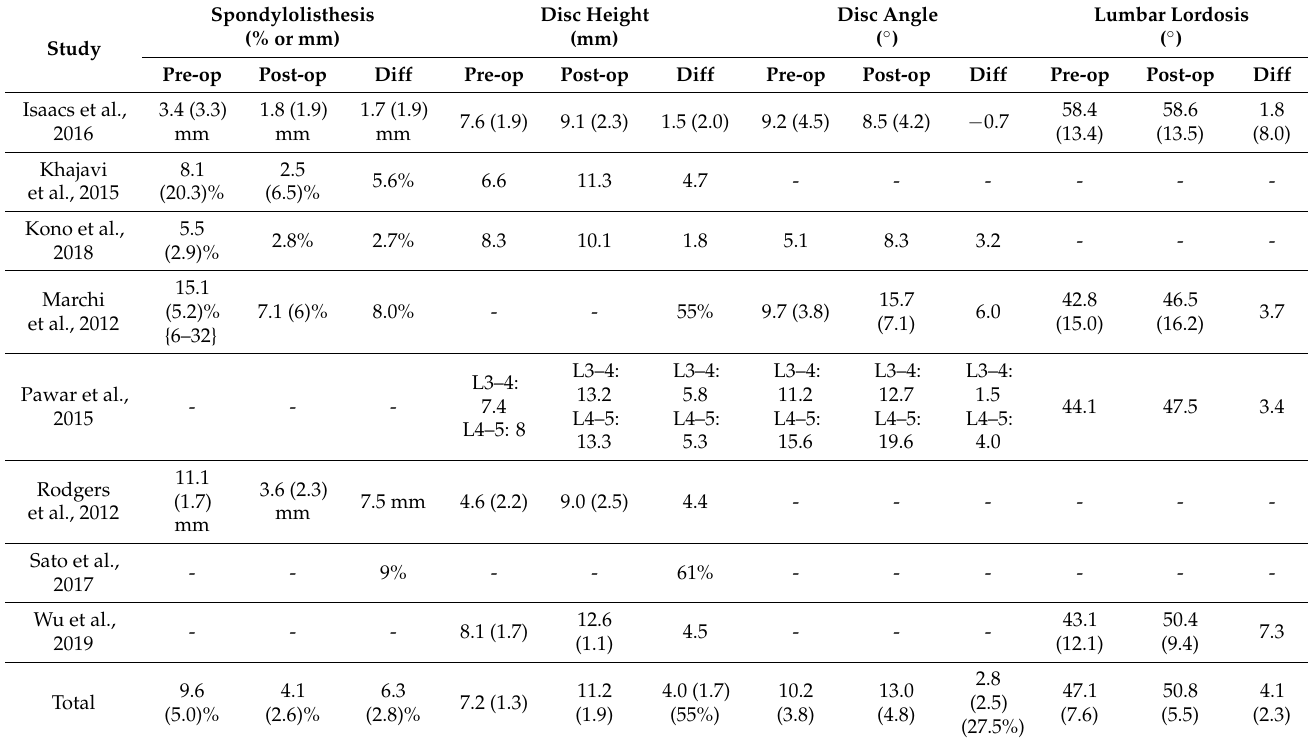
Table 5. Radiological outcomes by the included